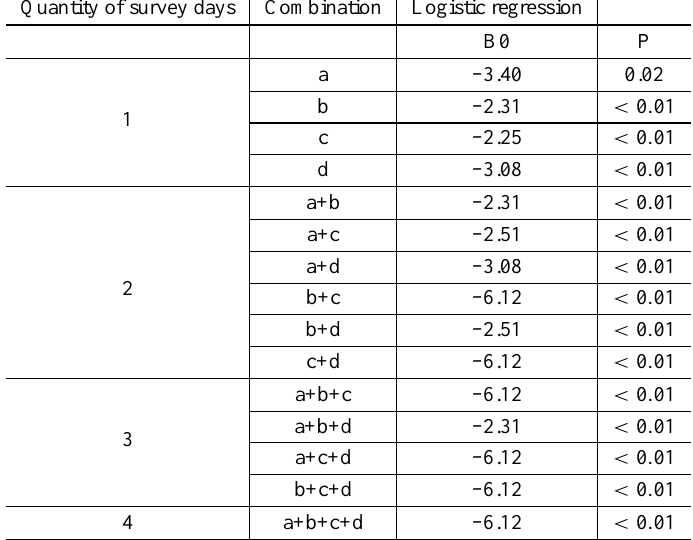
Logistic regression between species occurrences according to playback results and to abundance index (IPA) for T. surrucura . “Combination” indicates which survey days (a, b, c, d) were utilized in each test. P: significance level. B0 is the estimated logistic